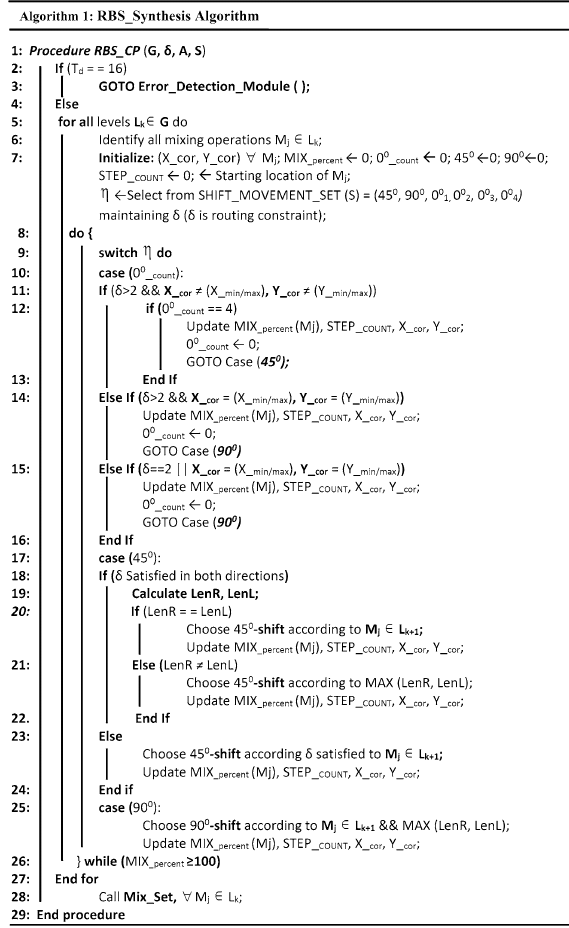
Fig. 10 Pseudocode for routing based synthesis on MEDA